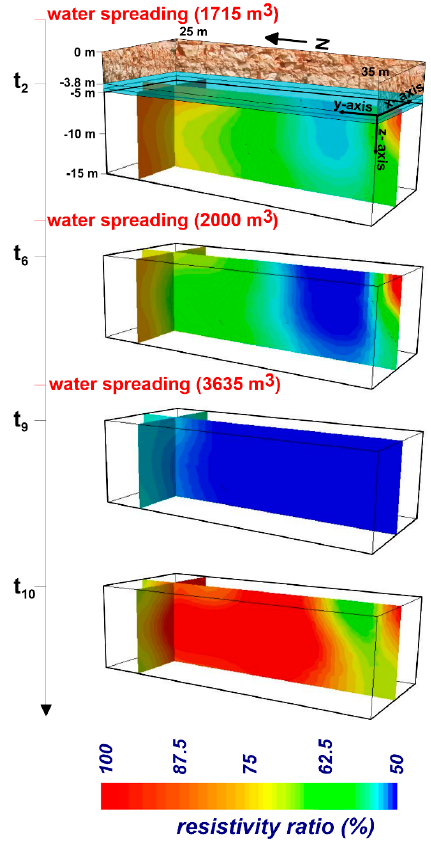
Figure 8. Resistivity ratio recorded for Trench 9 over the whole monitoring period at time: t 2 , 19 h after the spread of 1715 m 3 ; t 6 , 17 h after the spread of 2000 m 3 ; t 9 , 32 h after the spread of 3635 m 3 ; t 10 , at the end of the ERT monitoring.